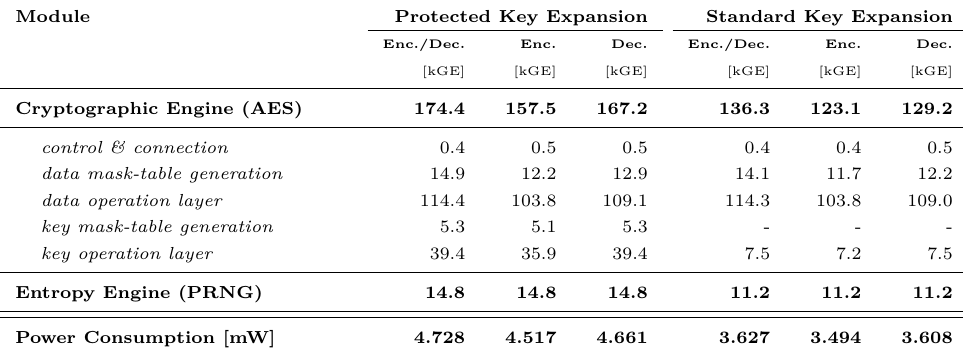
Table 2: Area and power results at 100 MHz after synthesis using GF28nm.